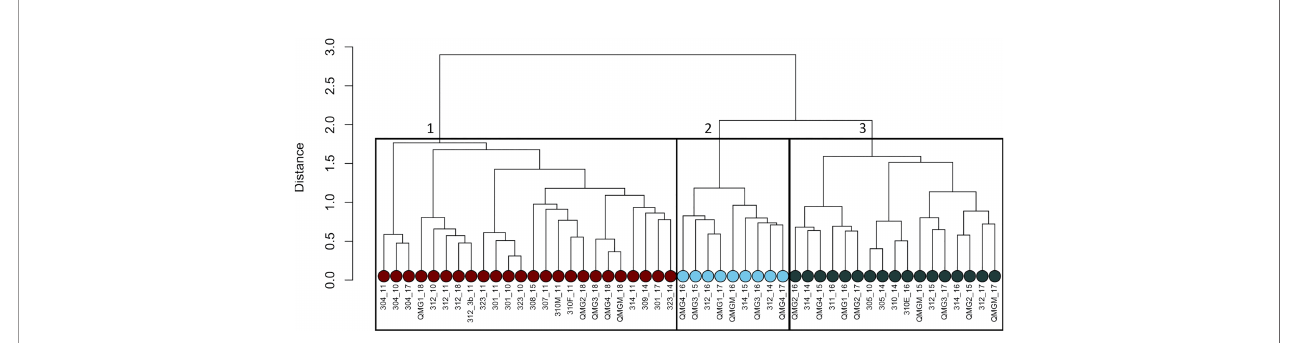
FIGURE 6 | Epifauna cluster tree based on Bray-Curtis dissimilarity matrix with Hellinger transformed species biomass data. Red dots are the stations from group 1, pale blue dots are group 2 and dark grey dots are group 3.